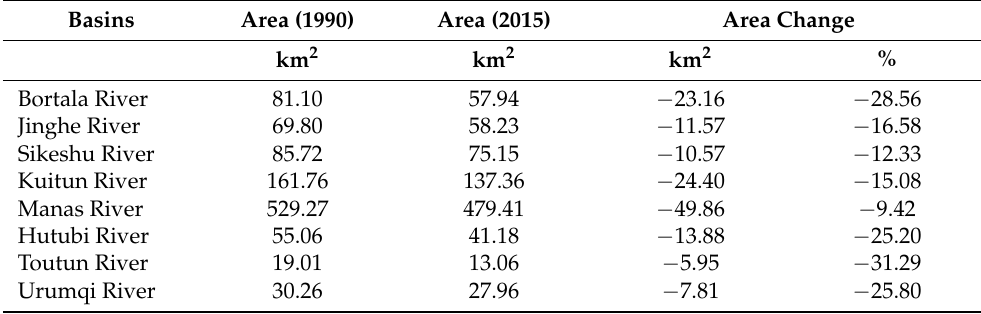
Figure 4. Spatiotemporal changes in glacier areas in different zones across the northern Tien Shan from 1990 to 2015. ( a ) Spatial changes in glacier areas; ( b ) temporal changes in glacier areas. Table 3. Changes in glacier area in different basins in the northern Tien Shan from 1990 to 2015.